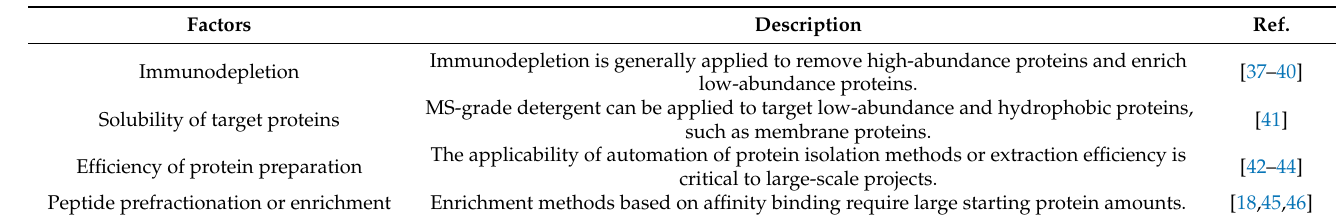
Table 2. Considered factors for protein sample